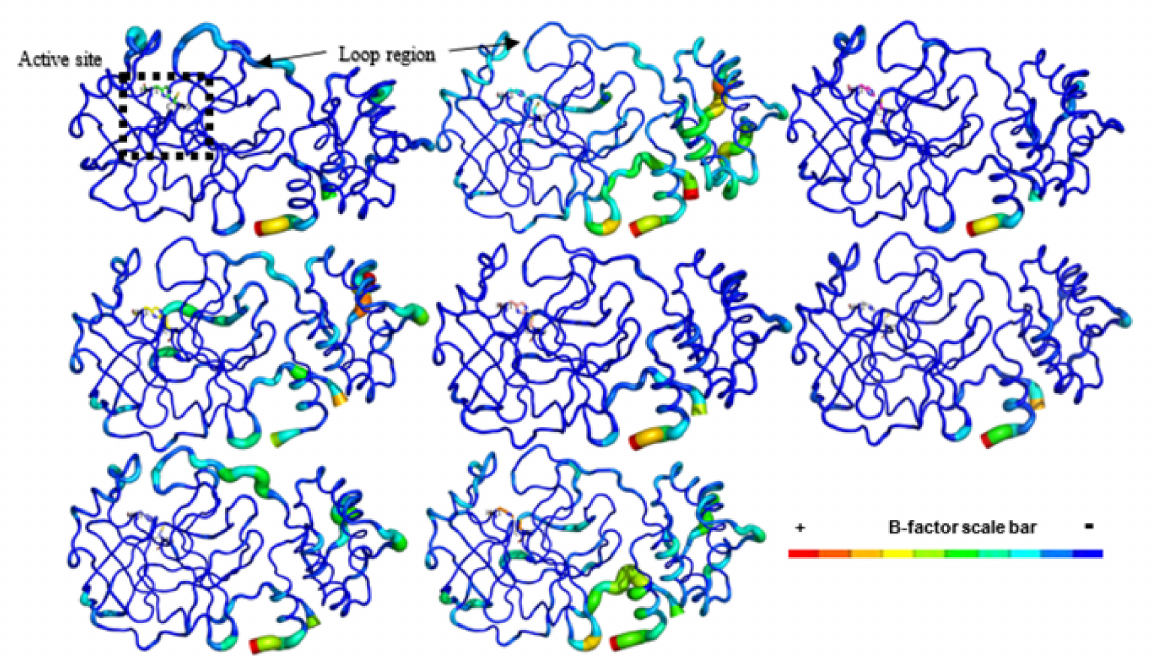
Figure 3. SARS-CoV-2 Mpro structures are shown in B-factor putty mode in PyMOL. The highest B-factor in each structure is colored in red and the lowest in dark blue, as indicated by the B-factor scale bar. The thickness of the protein backbone also is proportional to the B-factors. The catalytic residues (His41 and Cys145) are displayed as sticks. This image was generated by educational Pymol 2.4.1